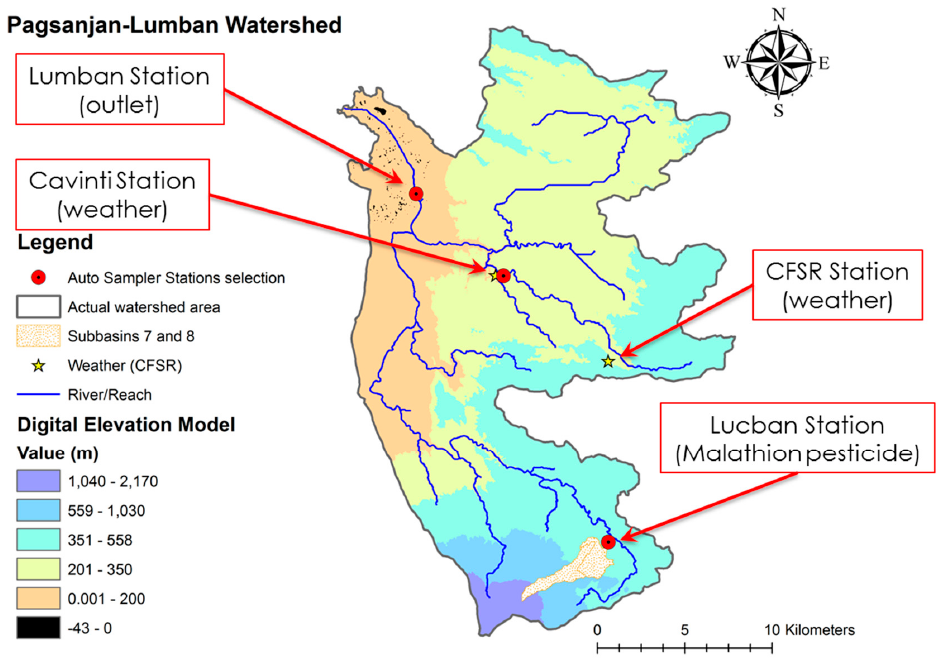
Figure 1. The digital elevation model of the Pagsanjan-Lumban watershed.